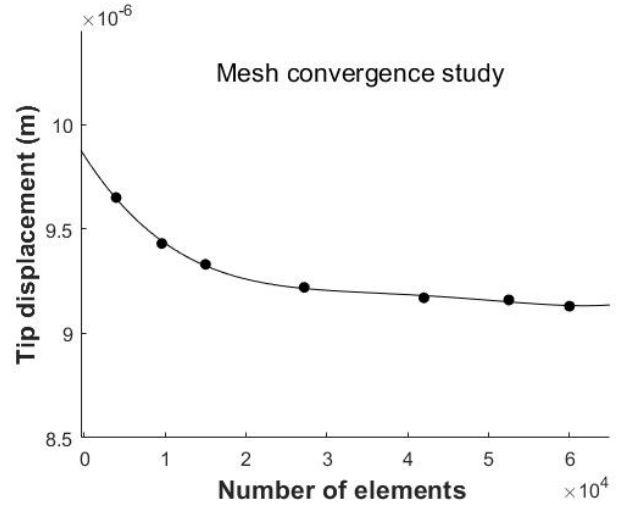
Figure 9. Tip displacement convergence plot. The surface distribution of the transverse shear deflection of the finite element simula- tion considering the nonlinearity and ESPI measurement at an applied voltage of 198 V are presented in Figure